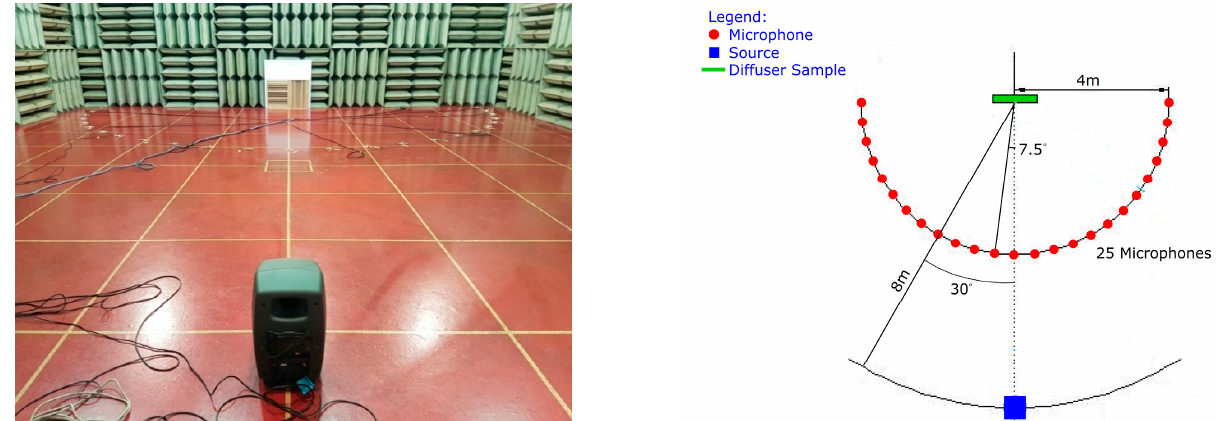
Figure 2. Equipment disposition inside the semi-anechoic chamber available at SCM Group in Rimini (Room A). Differently, in Room B the 25 microphones were installed at a radius of 5 m from the test sample, always located at the center of the semi-circumference, and the sound source was at a radius of 10 m distant from the test sample, as indicated in Figure 3.